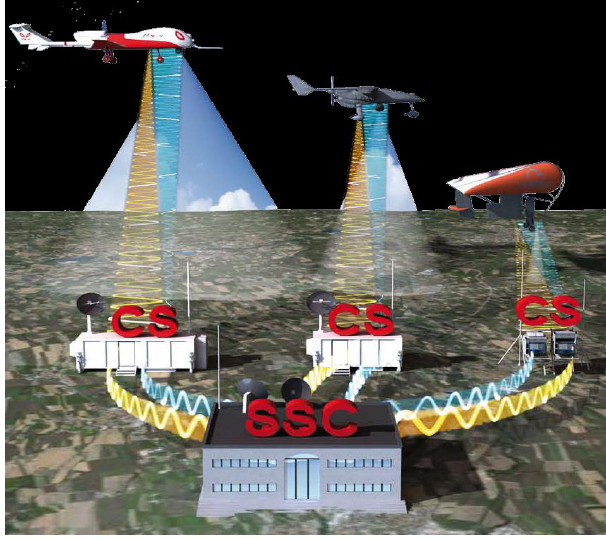
Figure 1. The main components of the overall SMAT-F1 system. Reproduced